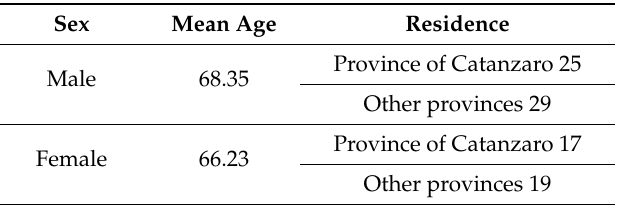
Table 3. Demographic characteristics of the study population.